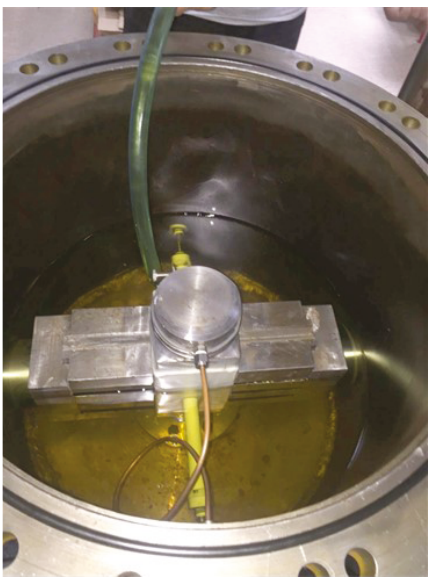
Figure 5: Photos of injecting hydraulic oil into the true triaxial pressure cell.